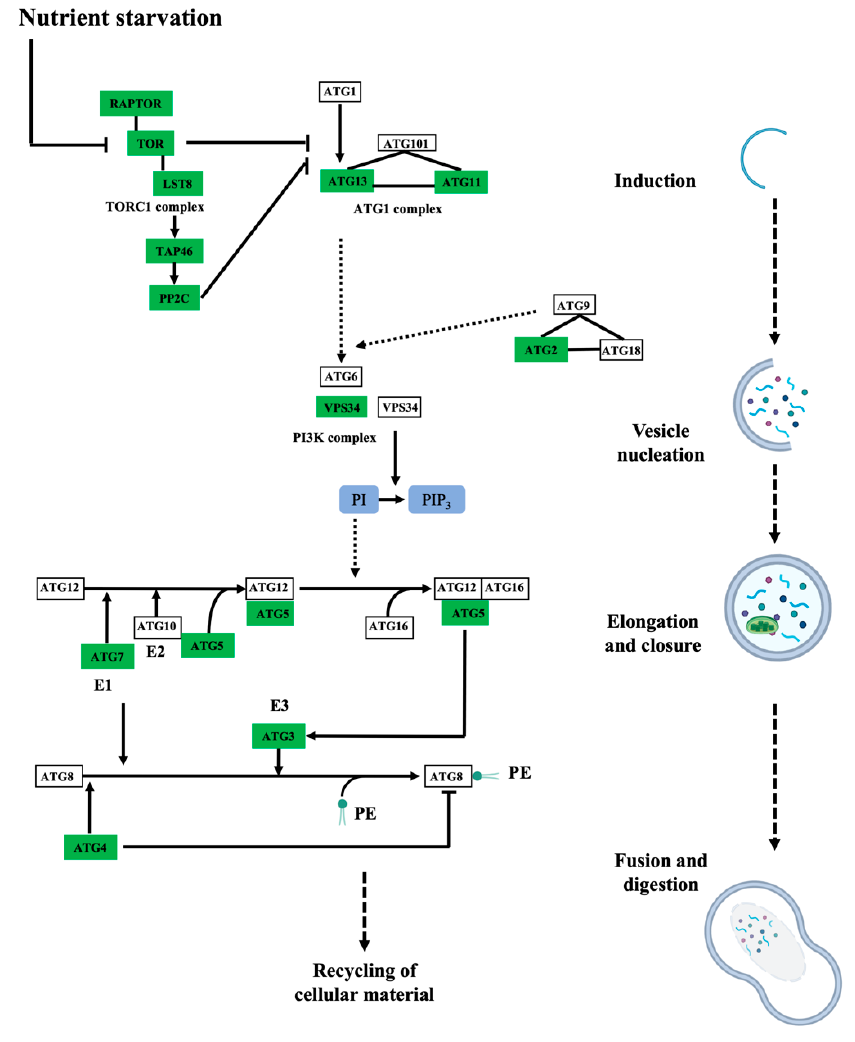
Figure 4. Persulfidated proteins identified in root tissues involved in autophagy. Simplified schematic drawing showing the persulfidated proteins identified as being involved in autophagy induction, vesicle nucleation, autophagosome elongation and closure, vacuole fusion and material digestion. The rectangular boxes represent the abbreviated name of the proteins involved in the autophagy pathway, and the green color of the boxes indicates proteins identified in this proteomic analysis. Adapted from the Kyoto Encyclopedia of Genes and Genomes (KEGG) Pathway database resource for pathway mapping.